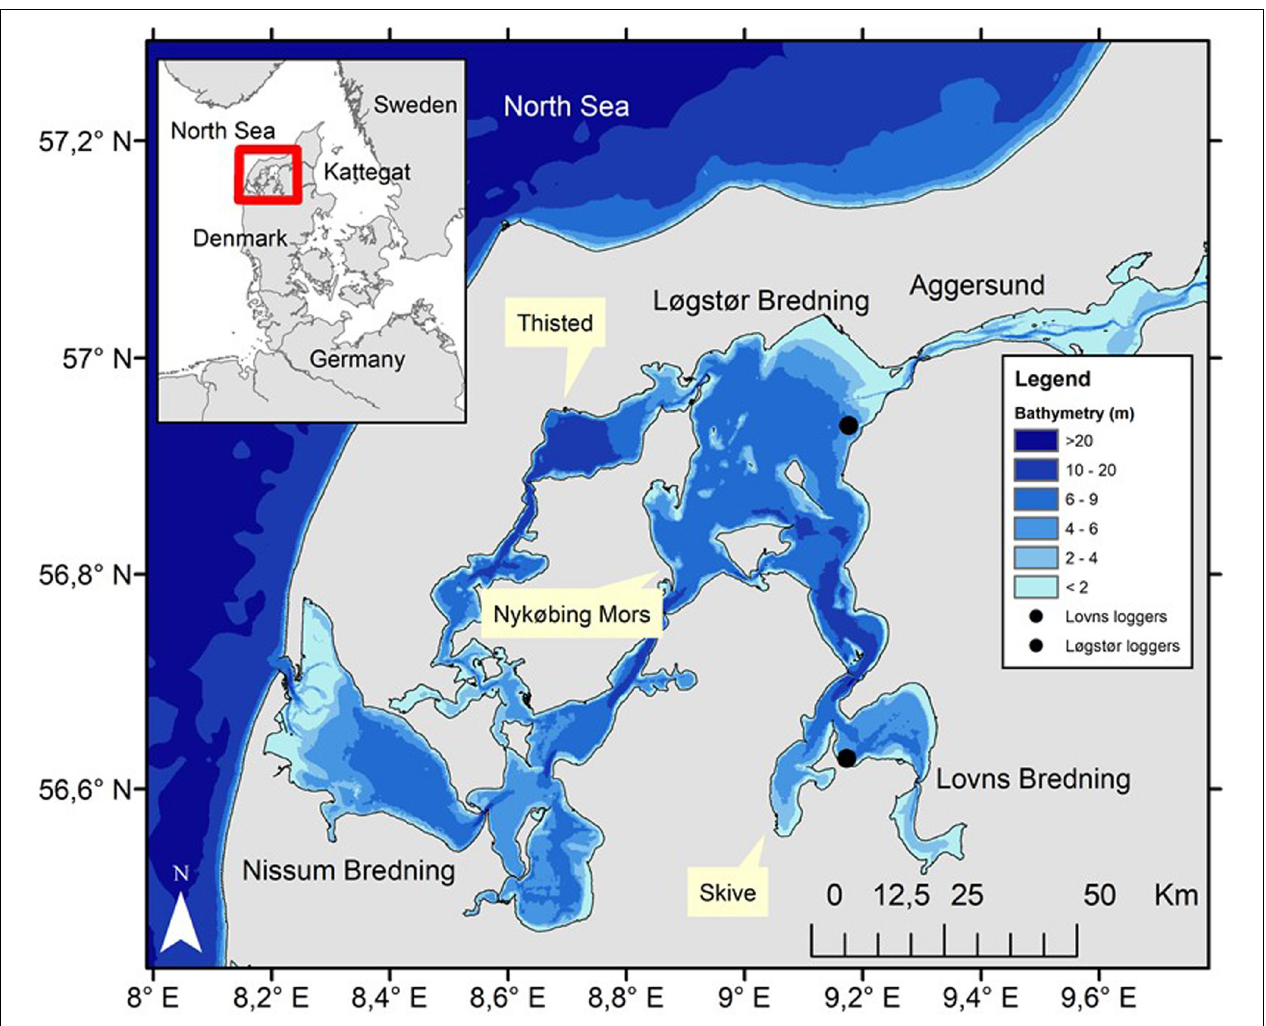
FIGURE 1 | Map of the central and western Limfjorden showing the dredging locations (Lovns and Løgstør). Color legend indicates the water depth and yellow text boxes indicate the major cities.